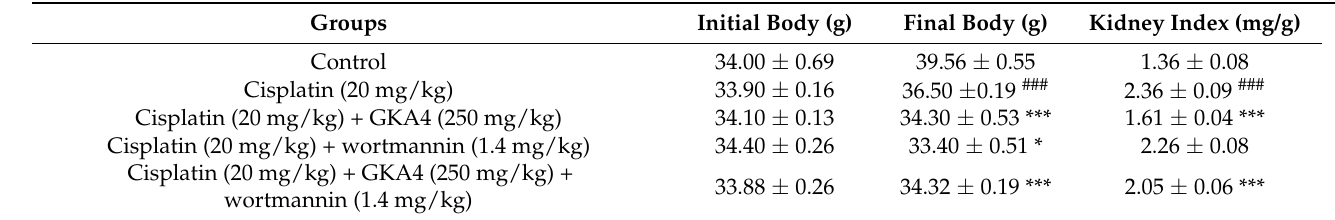
Table 2. GKA4 and the PI3K inhibitor (wortmannin) change the body weight and the kidney index, showing resistance to cisplatin-associated nephrotoxicity. The values were displayed as means ± S.E.M ( n = 5).